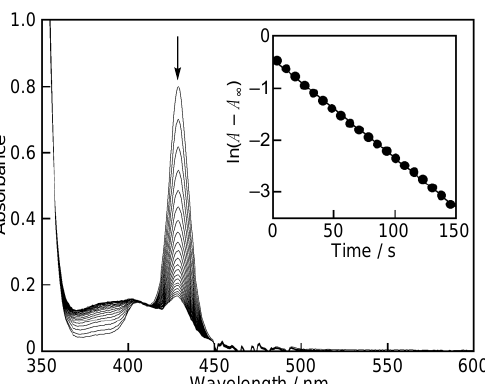
Figure 2. Spectral change observed every 7.5 s (once every fifth measurement) during the reaction of PTS (1.5 × 10 – 3 M) with GO • (1.0 × 10 – 5 M) in MeCN at 298 K. Inset: the first-order plot of the absorbance at 428 nm.